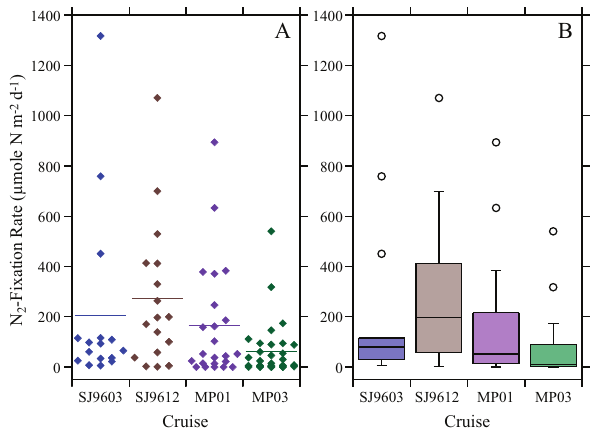
Fig. 2. Areal N 2 fixation rate measurements for Trichodesmium on cruises SJ9603, SJ9612, MP01, and MP02 within the region sampled by all four cruises (0 ◦ < latitude < 15 ◦ N and 40 ◦ < longitude < 60 ◦ W). A: Summary showing distribution of rates and overall mean rate (horizontal line) for each cruise. Individual points are offset laterally for clarity. B: Box plot summaries for the rate data from the four cruises. Each box spans the 25th and 75th quantiles of the data with the median shown by the line crossing the box. The whiskers extend to the 10th and 90th quantiles of the data when these are beyond the boundaries of the box. Open circles show outliers beyond the 90th